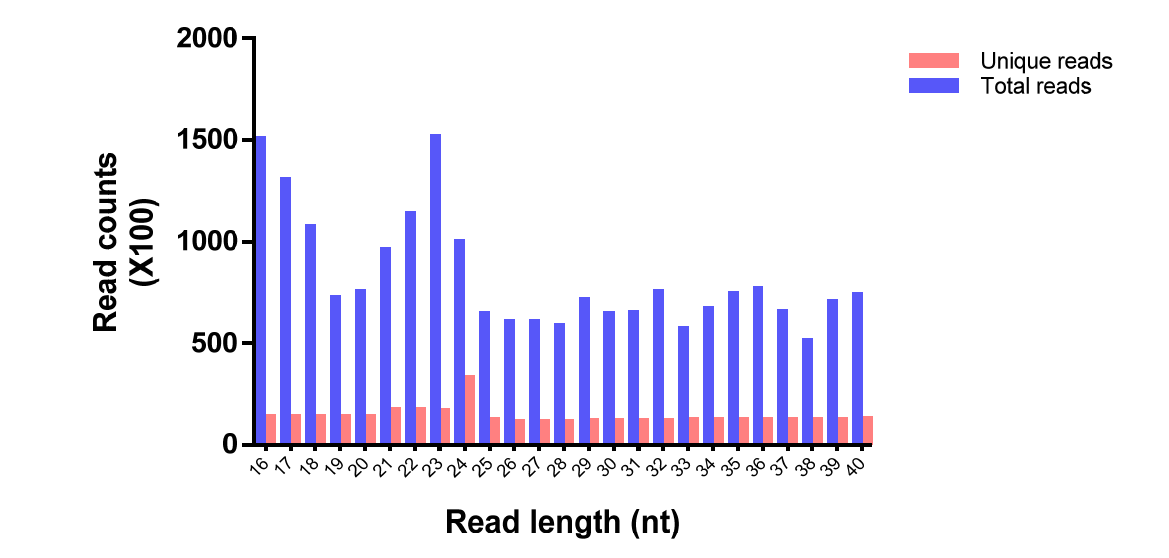
Figure 1. Length distribution and abundance of the small RNA sequences identified in M. koenigii leaves through Illumina sequencing.